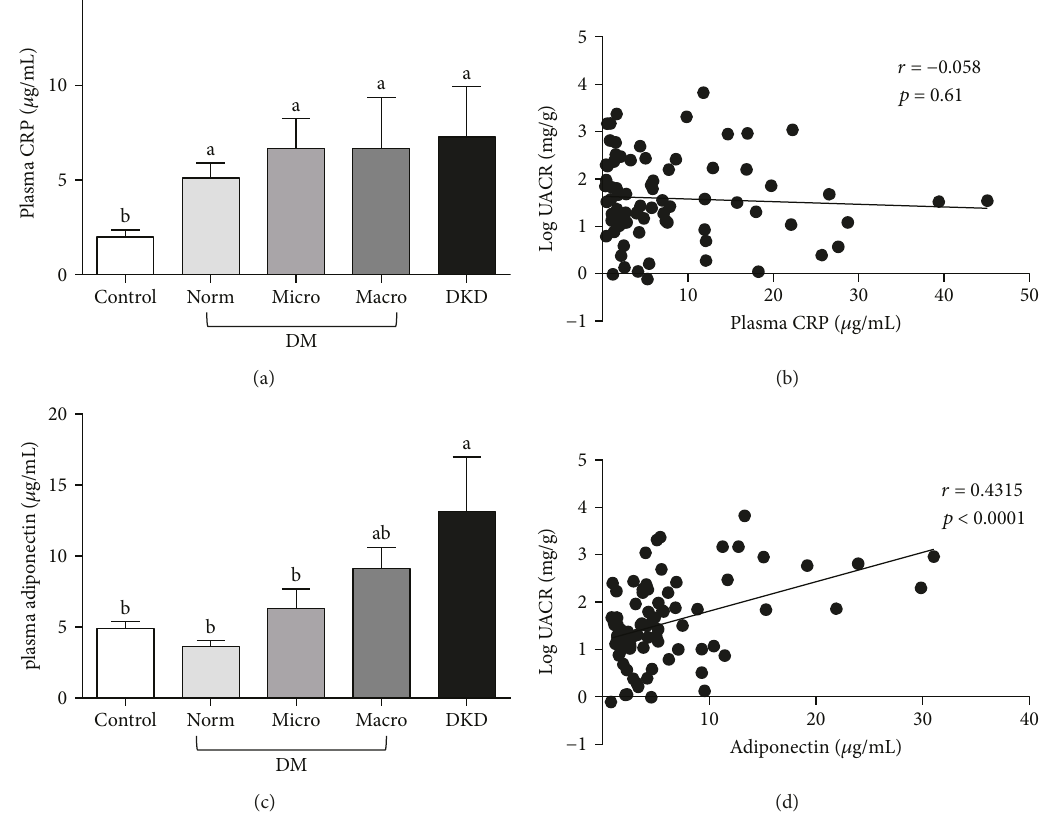
Figure 2: Plasma levels for C-reactive protein (CRP) (a) and adiponectin (c) in diabetic African American men and age-matched nondiabetic controls and diabetics with known DKD. The correlation between plasma CRP (b) or adiponectin (d) and log-transformed UACR in diabetic and DKD groups. Data are represented as mean ± SEM . Labeled means without a common letter are signi fi cantly di ff erent ( p < 0 05